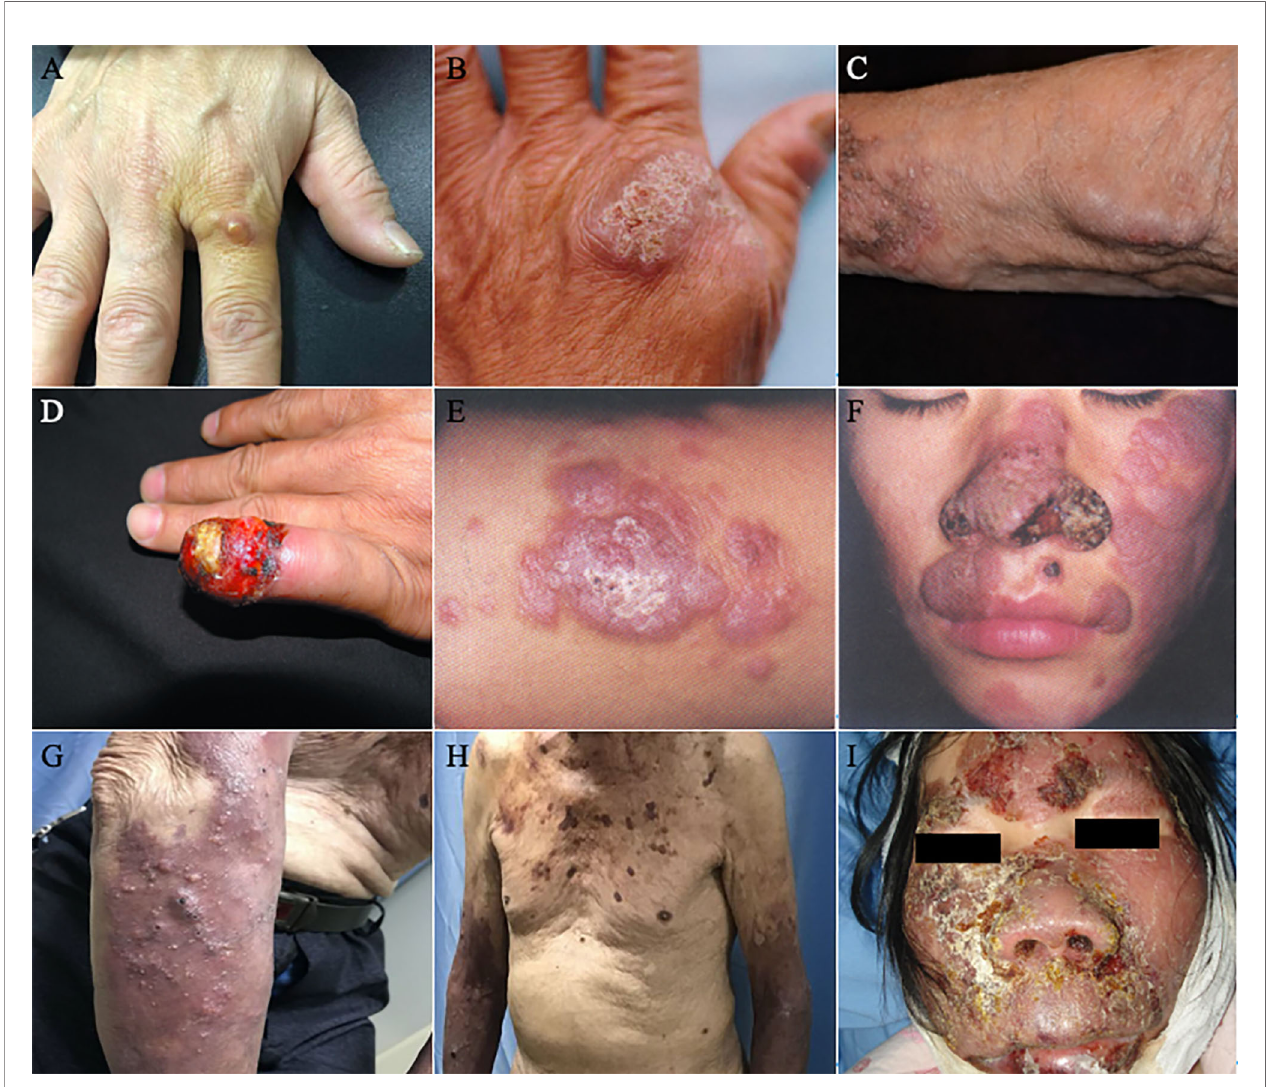
FIGURE 3 | Clinical types of lesions observed in patients with PHM. (A) Glossy papules lesions on the right hand. (Reproduced from reference Linqiang et al. (2020) [original Figure 1B ]) (B) Yellowish verrucous plaques on the left hand. (Reproduced from reference Chen et al. (2008) [original Figure 1A ]) (C) Sporotrichoid nodules lesions on the left forearm. (Reproduced from reference Yu et al. (2021) [original Figure 1D ]) (D) Swelling erythematous erosions and necrosis on the left little fi nger. (Reproduced from reference Lin et al. (2009) [original Figure 1 ]) (E) In fi ltrative erythematous plaques surrounded by little papules on the left forearm. (Reproduced from reference Wang et al. (2004) [original Figure 2 ]) (F) In fi ltrating red plaques on both sides of the face and the upper lip; dis fi guring verrucous plaques and ulcers on either side of the nasal ala. (Reproduced from reference Wang et al., (2004) [original Figure 1 ]) (G) (H) Nodules, papules, hemorrhagic vesicles, and pustules lesions on the bilateral forearm and trunk. (Reproduced from reference Pan et al. (2021) [original Figure 1A, B ]) (I) In fi ltrative swelling erythematous plaques on the face with purulent, smelly discharge. (Reproduced from reference Yan et al. (2016) [original Figure 1A